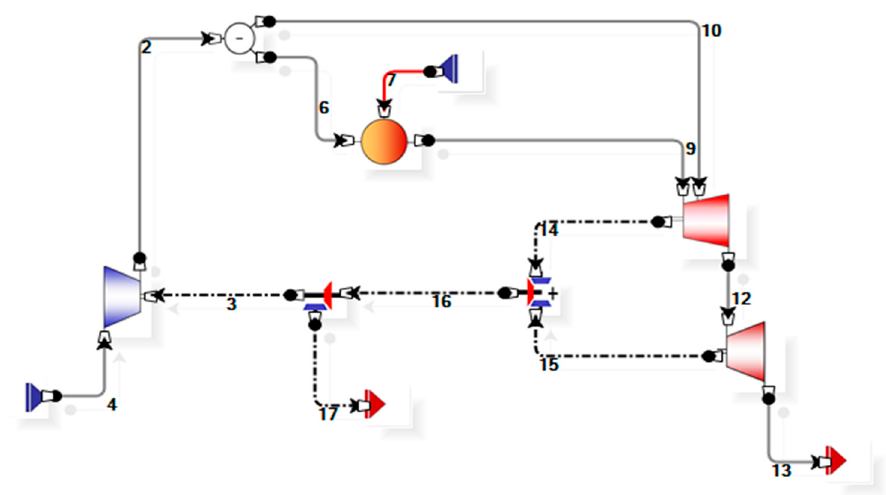
Figure 3. Schematic representation of the gas turbine in CAMEL-Pro TM simulator. Table 1. Design parameters values kept constant throughout all simulations.